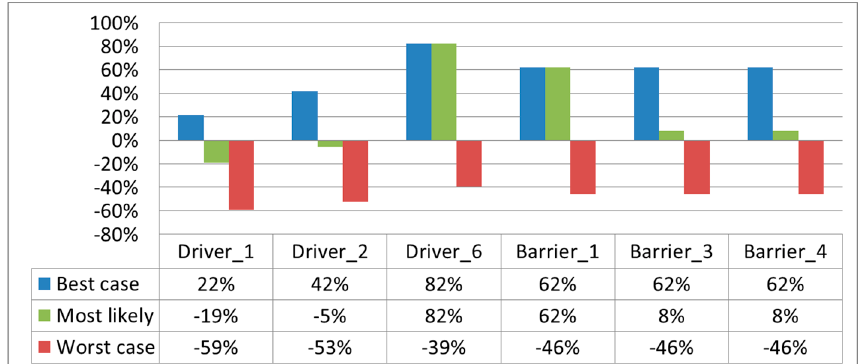
Figure 9. Most likely percentage of relative variation of self-consumption potential in Spain by variable and scenario with respect to static (own elaboration).